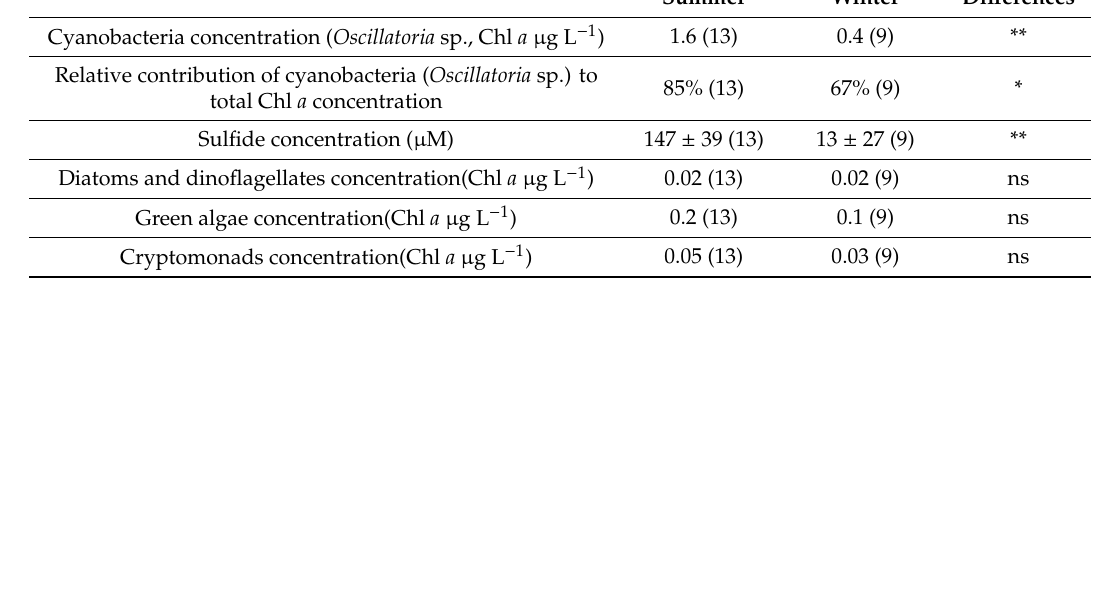
Relative contribution of cyanobacteria ( Oscillatoria sp.) to total Chl a concentration Sulfide concentration ( µ M) Diatoms and dinoflagellates concentration(Chl a µ g L − 1